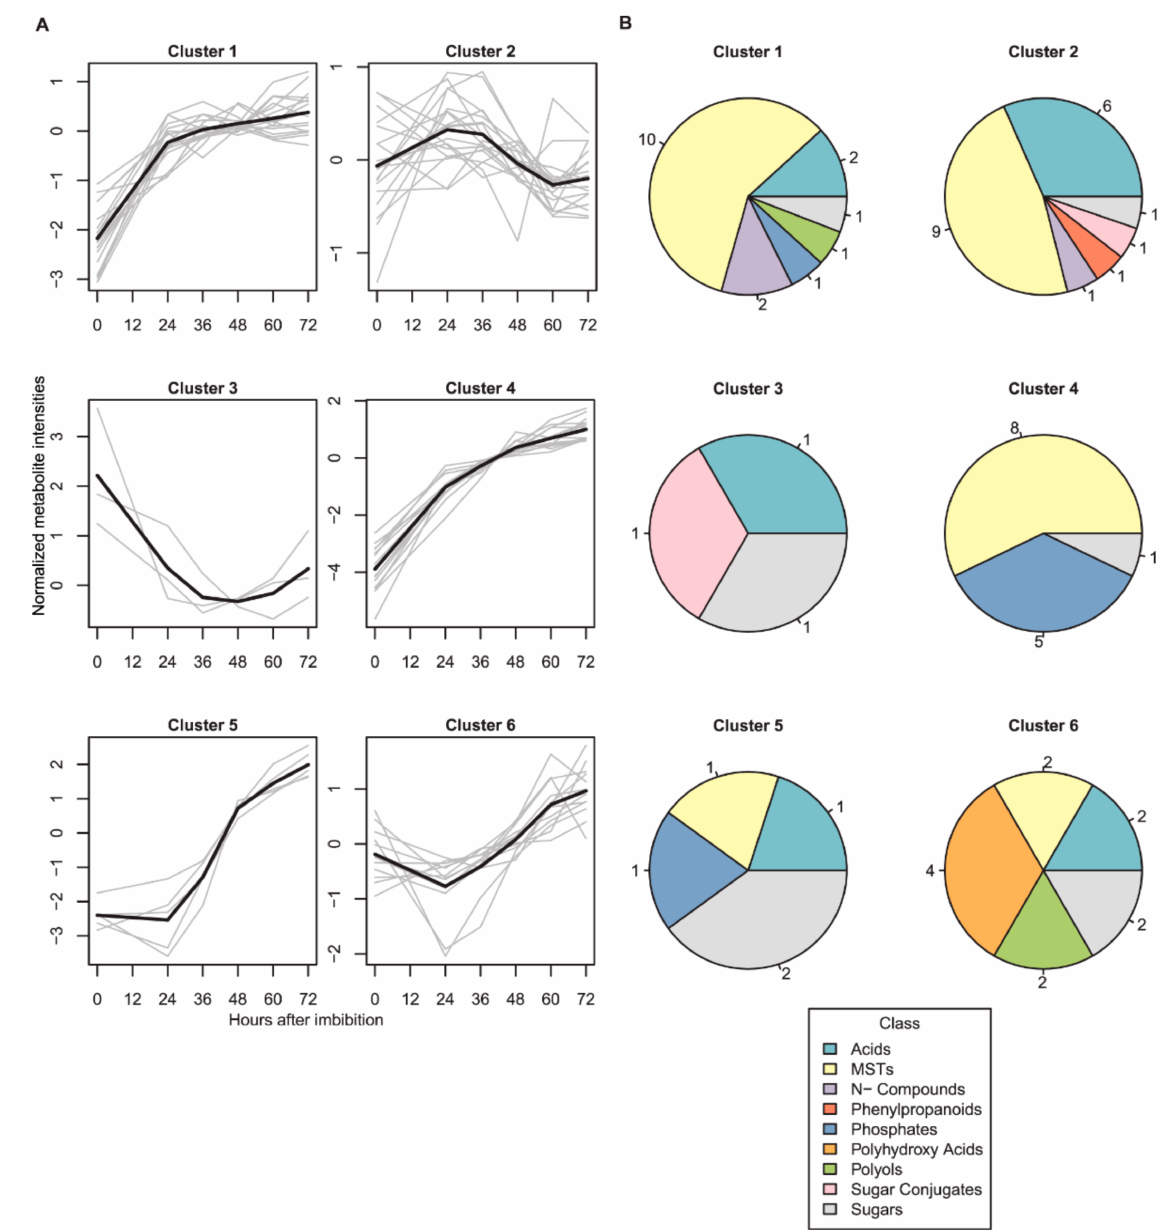
Figure 2. Patterns of metabolite abundance as determined by k-means clustering (clusters 1–6) (see Supplemental Figure S2) ( A ). Gray lines represent individual metabolites while black lines show the mean of each cluster. ( B ) Distribution of metabolite classes in each cluster. Amino acids were considered separately. Each chemical class is represented by a unique color as shown (MSTs = mass-spectral tags). Numbers around the pie charts represent the numbers of class